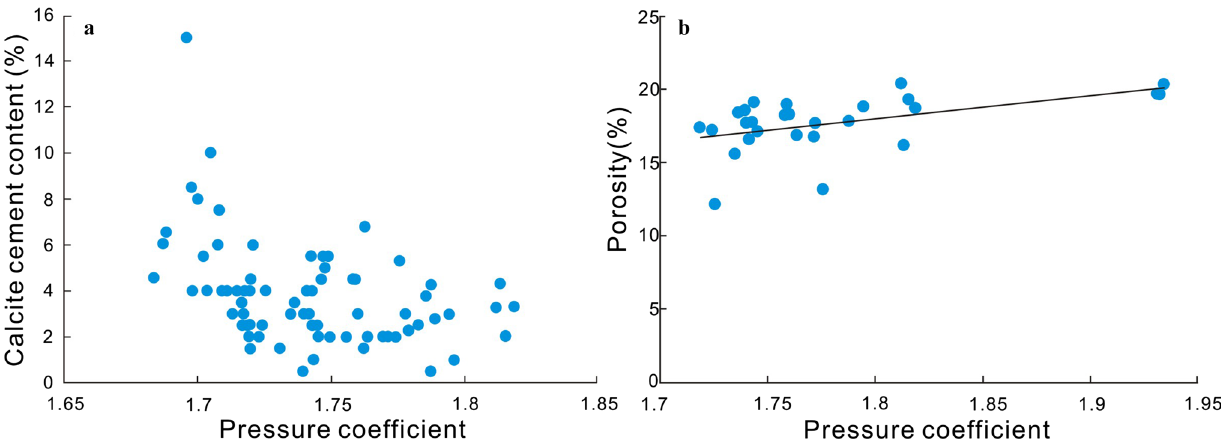
Fig. 11 a Cross plots of pressure coefficient and calcite cement con- tent of sandstones in the Upper Xiaganchaigou Formation (E 32 ) in the Lengdong area, Qaidam Basin. b Cross plots of pressure coefficient